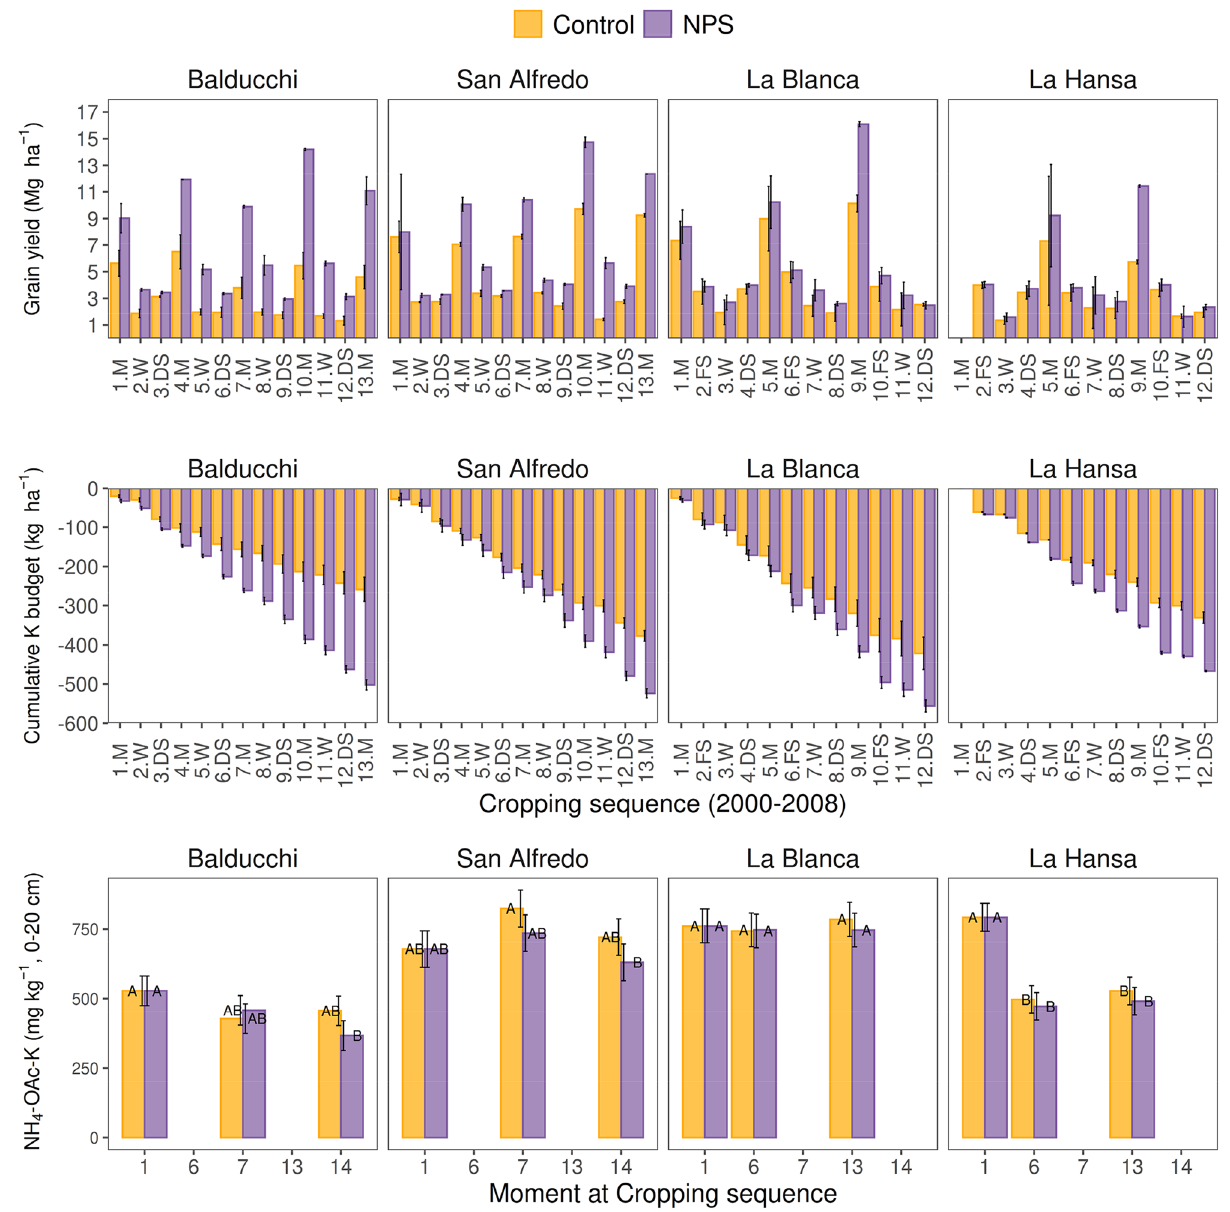
site under two different cropping sequences (Table 1) from 2000 to 2009. Each observation is the average of three replicates. Error bars represent the standard deviation for grain yields, and standard errors from their respective analyses of variance for cumulative K budget and topsoil NH 4 -OAc-K (Tukey’s HSD, p < 0.05). Within each site, different letters indicate significant differences between NH 4 -OAc-K levels at 0–20 cm for treatment- moment at the sequence combinations (Tukey’s HSD, p < 0.05). M maize, W wheat, DS double cropped soybean, FS full season